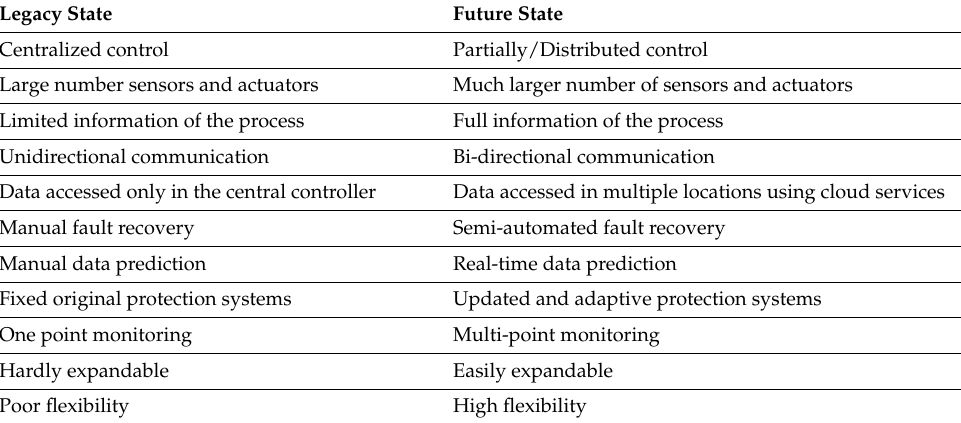
Table 1. Manufacturing cell actual and future states